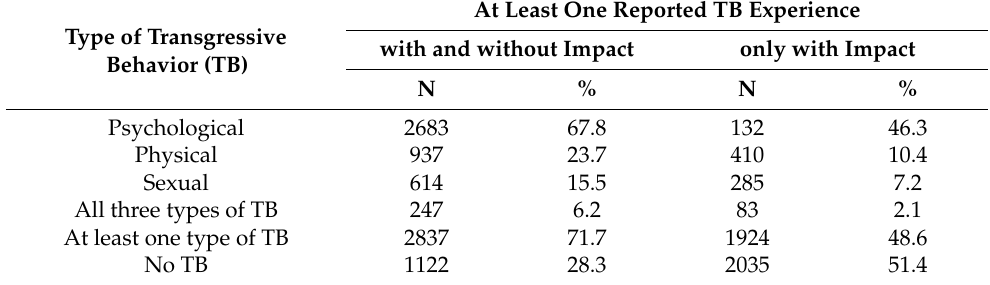
Table 3. Overview of the frequency of self-reported TB experienced during participation in organized youth sport.